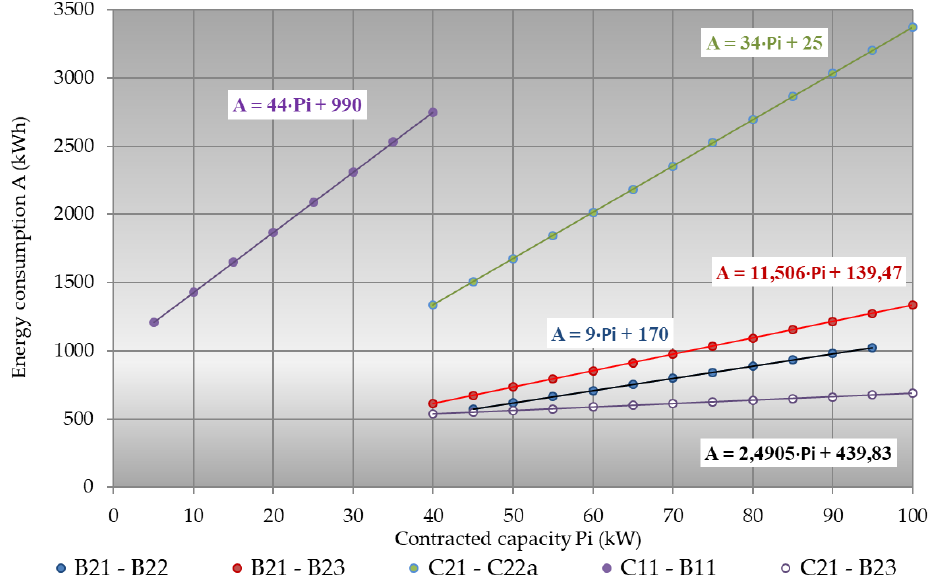
Figure 6. Breakeven of energy tariff change depending on the level of contracted capacity (Pi (kW)) and monthly energy consumption (A (kWh)).